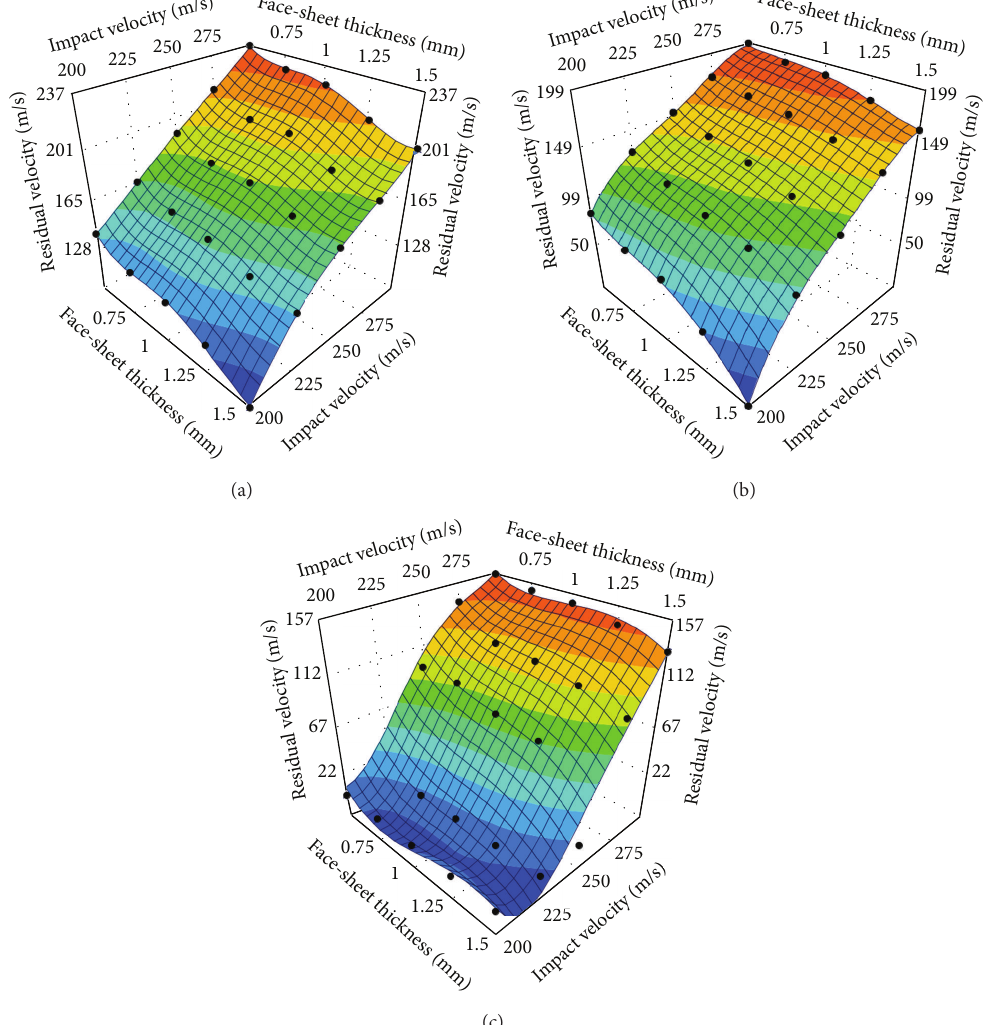
Figure 14: Quartic polynomial approximations of the residual velocity of projectile impact on auxetic HSPs with different face-sheet thicknesses. The bold black dots in the plots show the training points. (a) 𝑇 𝑐 = 30 mm, (b) 𝑇 𝑐 = 50 mm, and (c) 𝑇 𝑐 = 70 mm ( 𝜌 = 0.15 ).